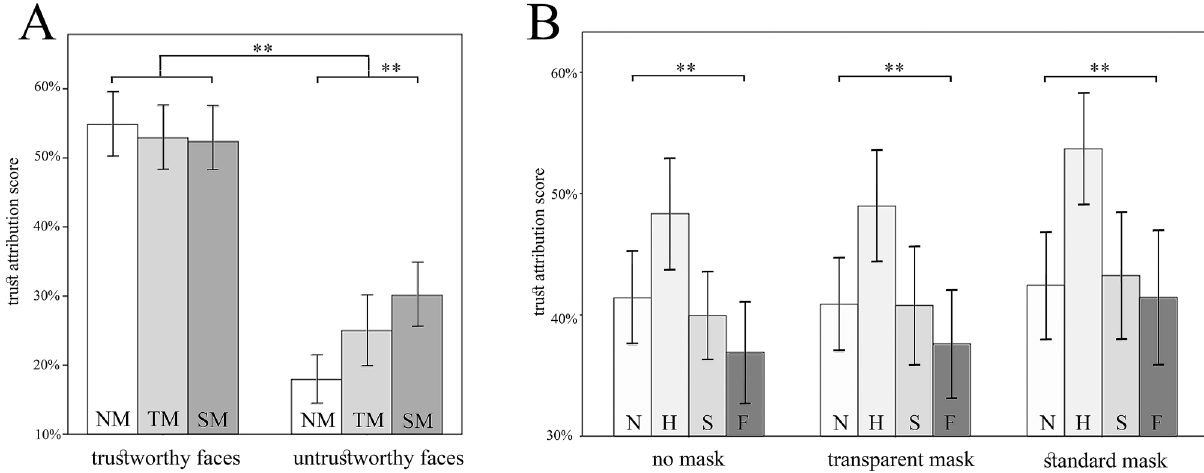
Figure 3. Trust attribution task. ( A ). Results for trustworthy and untrustworthy CFD faces, showing a significantly lower score for untrustworthy faces. Stimuli rated as untrustworthy shows a significant effect of Condition. See Table 1 for post-hoc results. ( B ) A main effect of Emotion was observed in each of the three conditions (NM, TM, SM) of the KDEF stimuli, with Happiness obtaining the highest scores. See Table 1 for post-hoc results. All conventions as in Fig.